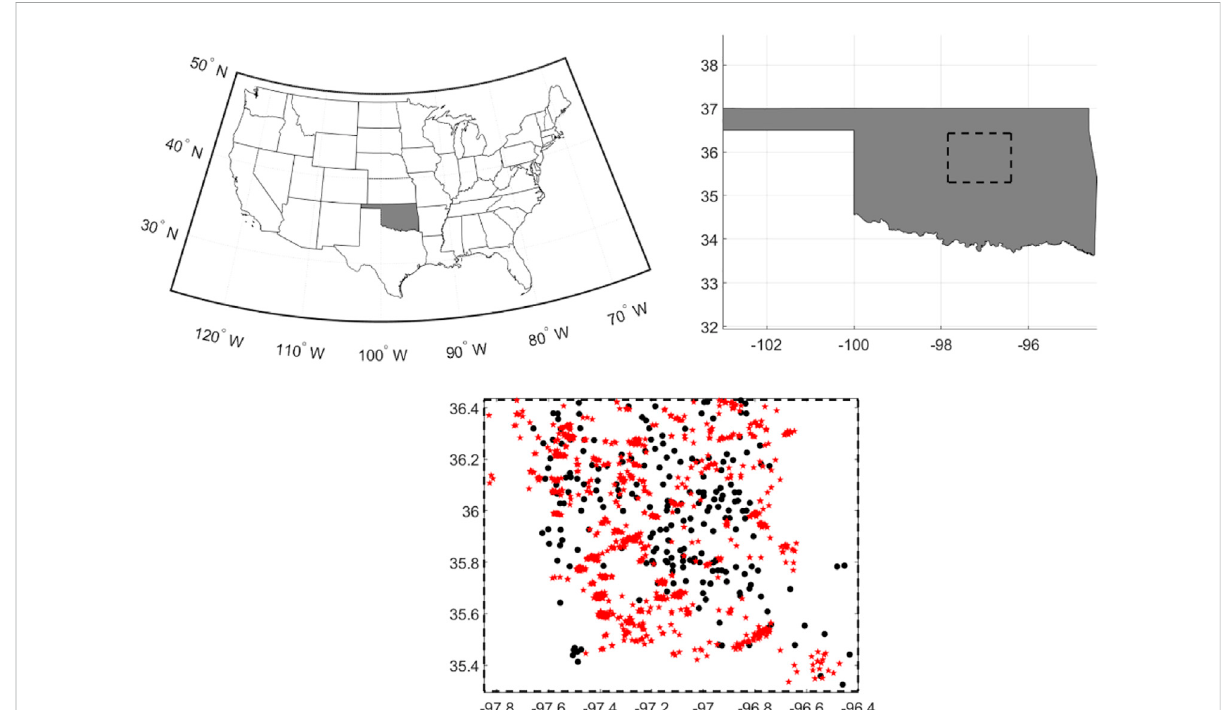
MapsoftheOklahomastate inUnitedStatesshowing:(i)theareaofinterest(dashedcontourintop-rightmap),(ii)thelocations oftheArbuckle wastewater disposal wells (black dots in bottom-centre map), (iii) and the M w 3+ earthquakes which nucleated in the basement between 3 and 7 km depth and from 1995 to 2017 (red stars in the bottom-centre